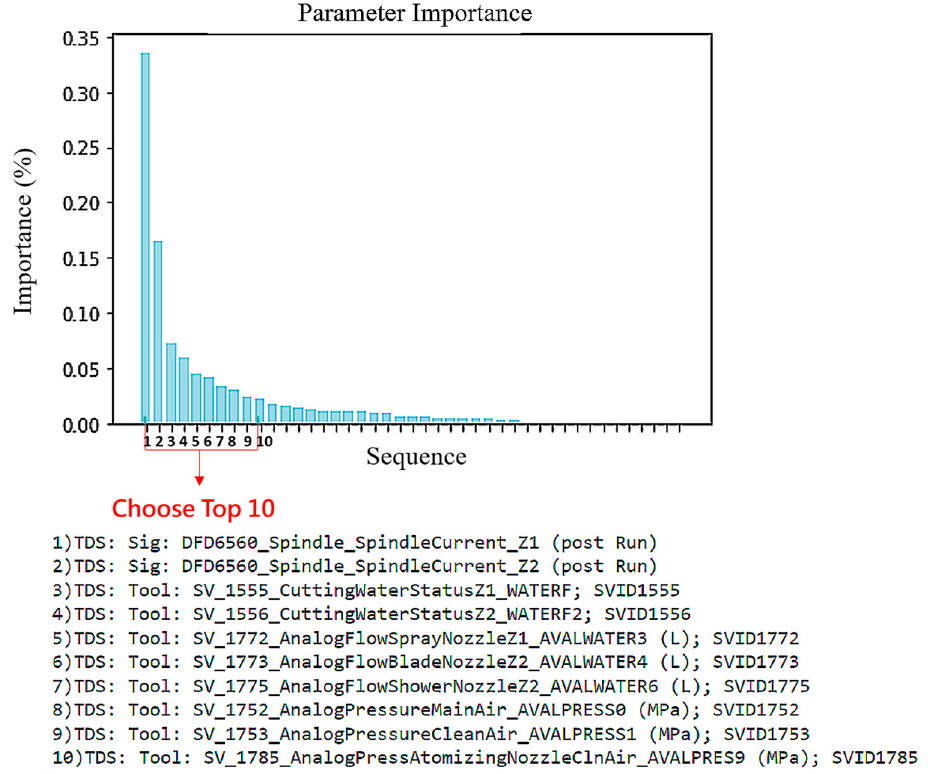
Figure 13. Important parameters in wafer